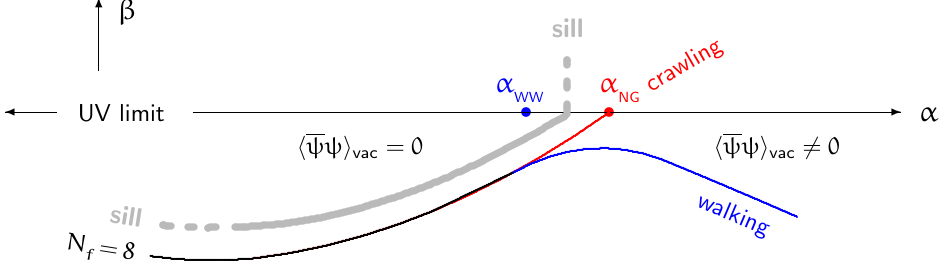
Figure 5. Competing explanations for the appearance of a scalar particle in lattice data for SU ( 3 ) gauge theory with N f = 8 triplet fermions. Two IRFPs are shown: (a) the closest scale-free IRFP α WW just < N inside the conformal window, N c f (cid:54) 16, and (b) a scale-dependent IRFP α NG for N f = 8 (cid:54) N f Walking TC assumes that α NG is not present. Instead, the small scalar mass is supposed to arise at an intermediate energy where the curve is closest to the axis, and then the theory chooses the blue line labelled “walking” to approach the infrared region. In crawling TC, the N f = 8 theory enters the infrared region as it approaches the axis and chooses the red line labelled “crawling”. The short length of the red line accounts for the small mass acquired by the type-I